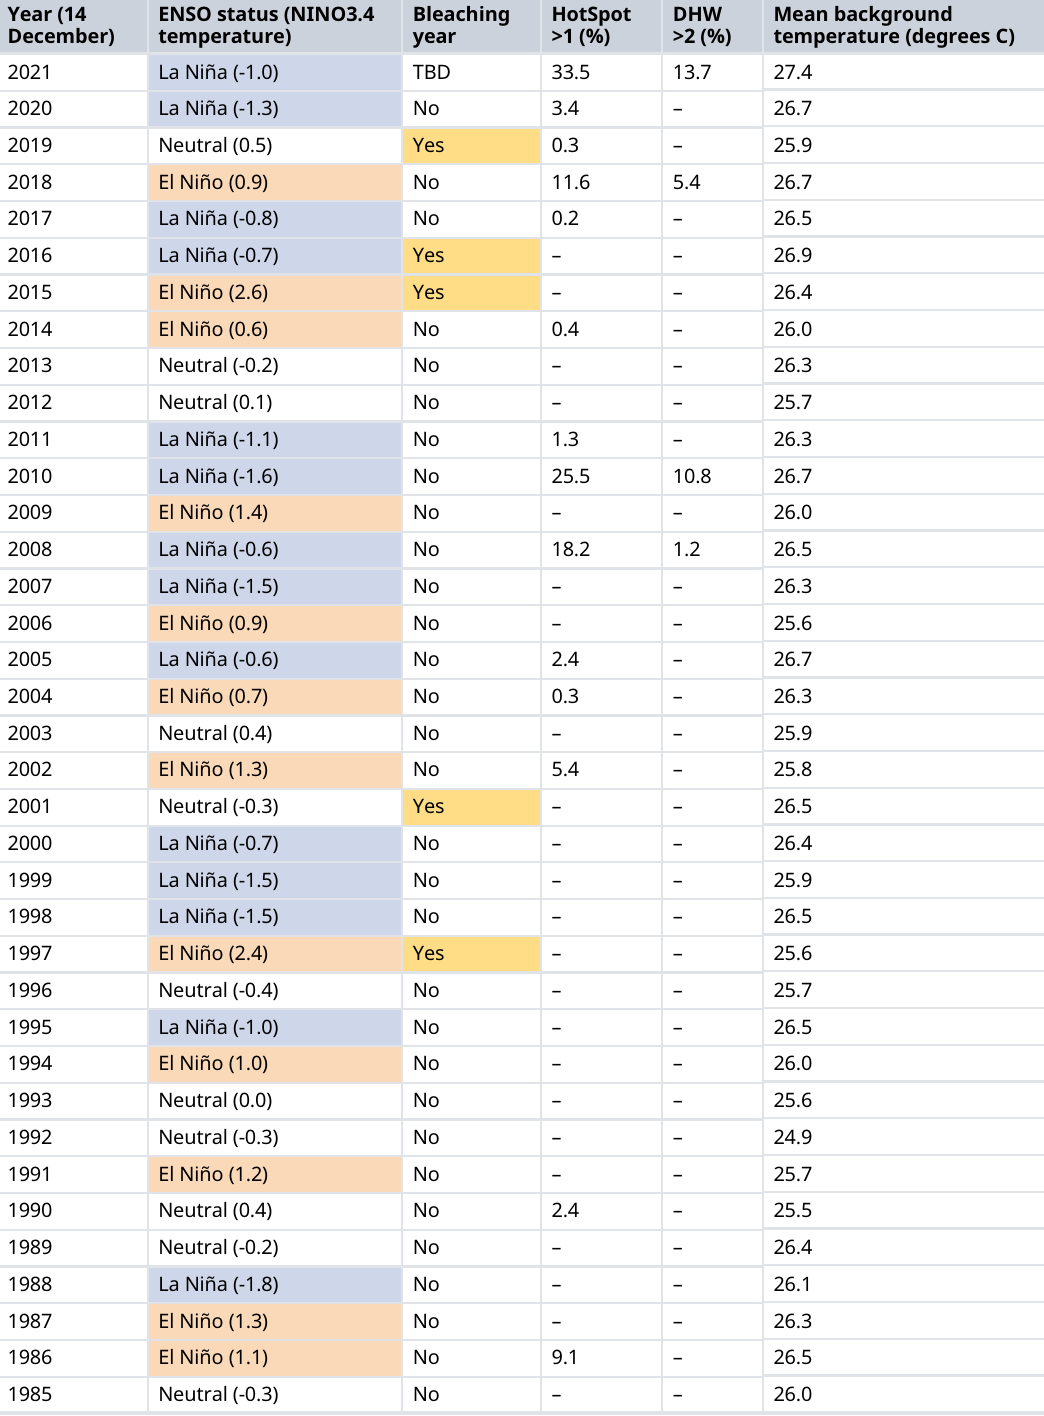
Table 1. Summary of annual heat stress conditions from 1985 to 2021. For each year, as of 14 December, the El Niño Southern Oscillation (ENSO) status (October-December) including the NINO3.4 temperature (degrees C); if therewasanoccurrenceofamassbleachingeventontheGreatBarrierReef(GBR)duringthefollowingsummer;the percentage of the 5,274 GBR 5 km satellite pixels that had a HotSpot > 1; the percentage of GBR pixels with a Degree Heating Week (DHW) > 2; and the mean background temperature for all GBR pixels. Cells within the table containing ‘–’ indicateavalueofbetween0.0%to0.1%oftheGBRpixels. [Note:LaNiñaconditionspresentinDecember2016didnot persist past January 2017; bleaching did not commence until February